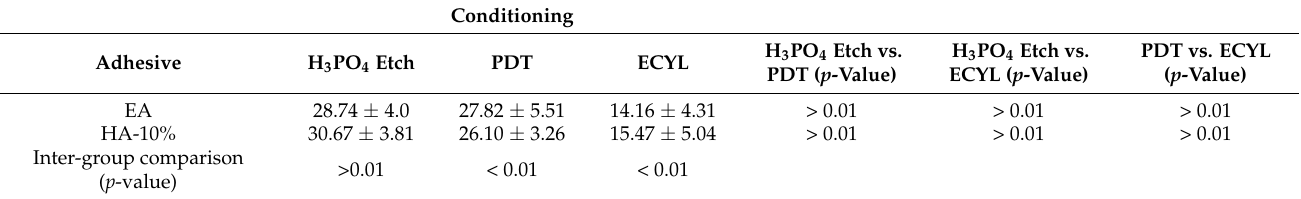
Table 2. Percentage distribution of interfacial failure types among the study